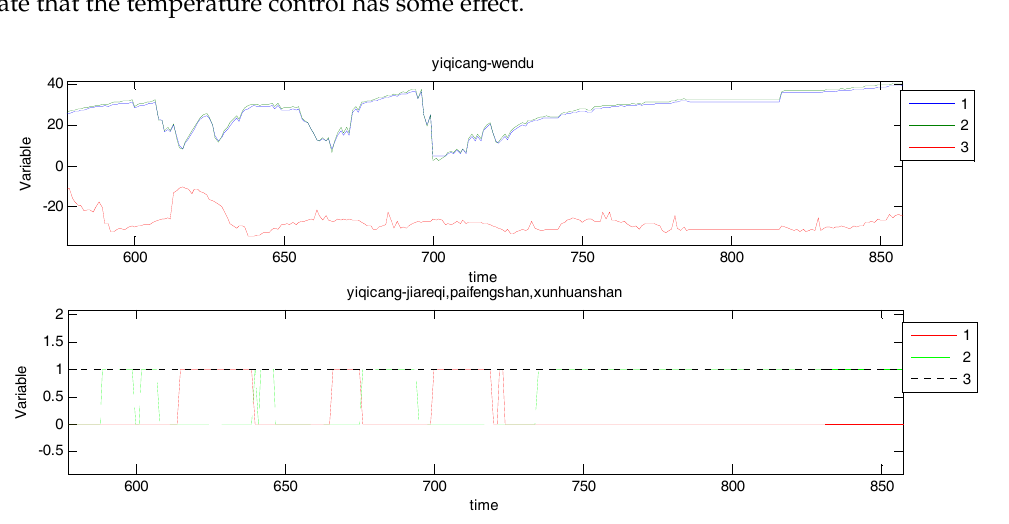
Figure 6. (2011.01.13~2011.01.18) the equipment module cabin inside and outside temperature curve; the heater, the exhaust fan, and the circulation fan work curve. In the first picture, the red curve is the cabin outside temperature measuring value, and the blue and the green are the cabin’s inside temperature values. In the second picture, the solid red line is the heater, the green dotted line is the exhaust fan, and the black point line is the circulation fan; 0_value represents being power o ff and 1_value represents being power